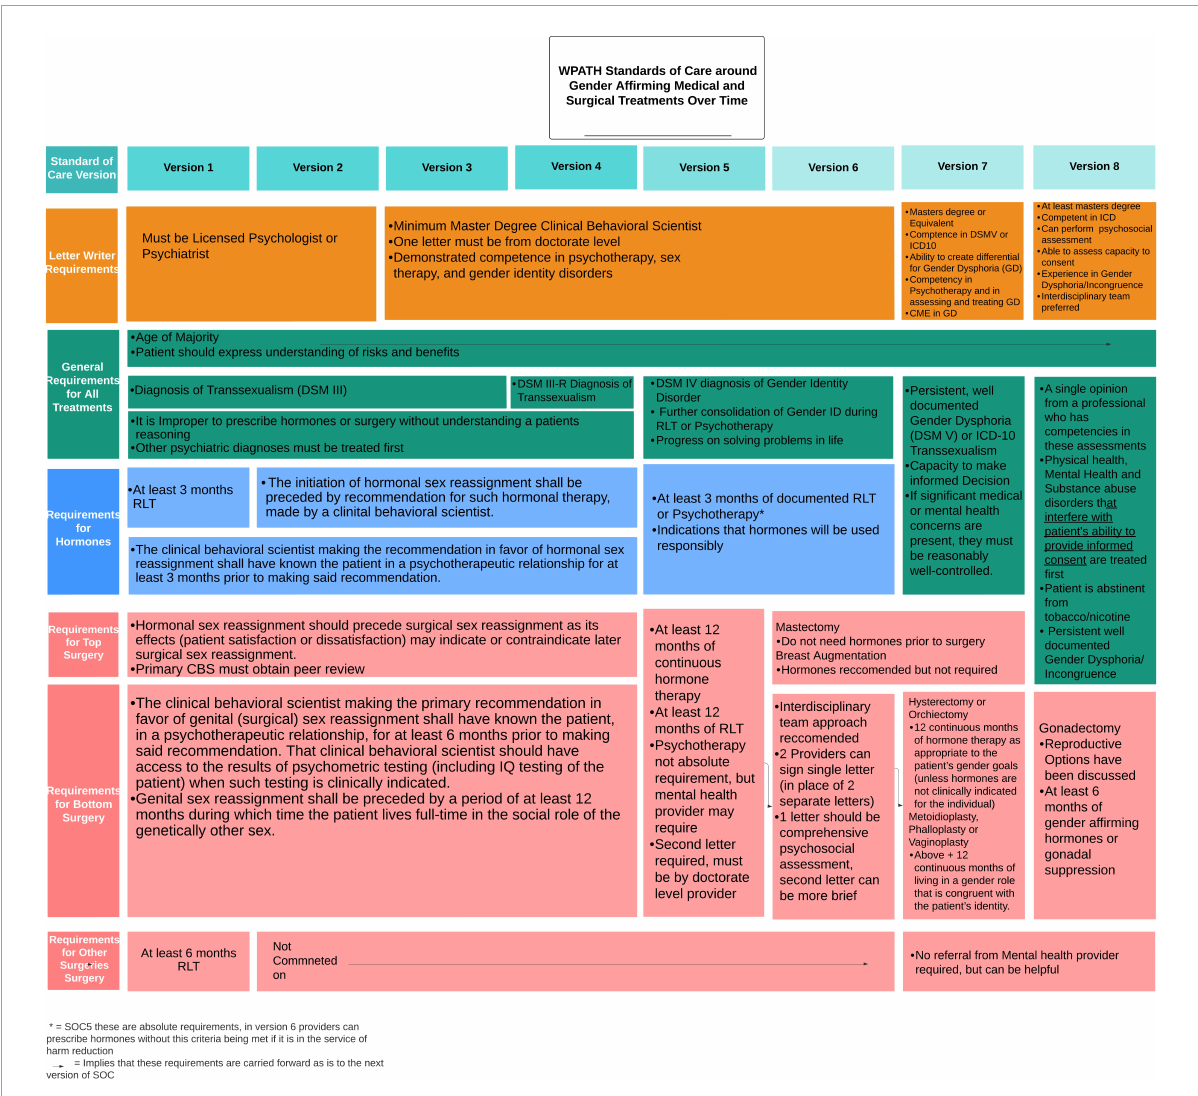
FIGURE2 Changes to the World Professional Association for Transgender Health (WPATH) standards of care around gender affirming medical and surgical treatments over time.